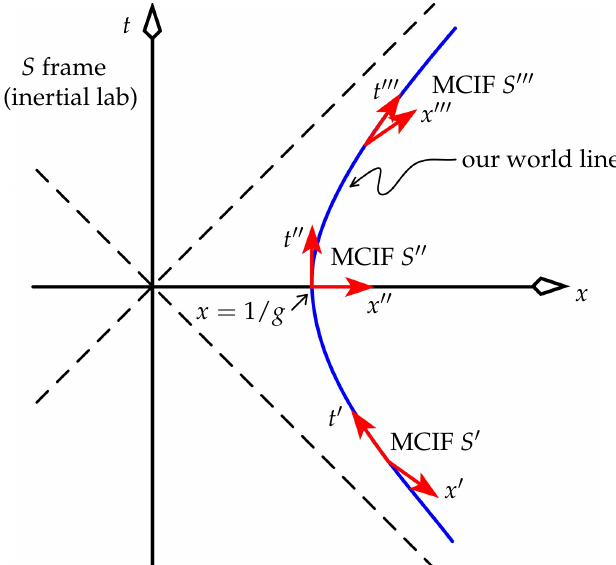
Figure 1. Our hyperbolic world line in the inertial frame S of the lab. Included are a selection of the infinite number of our MCIFs. The positive- x direction is “up” for us, in the sense that we feel a force pressing us into our seats “downward” in the negative- x